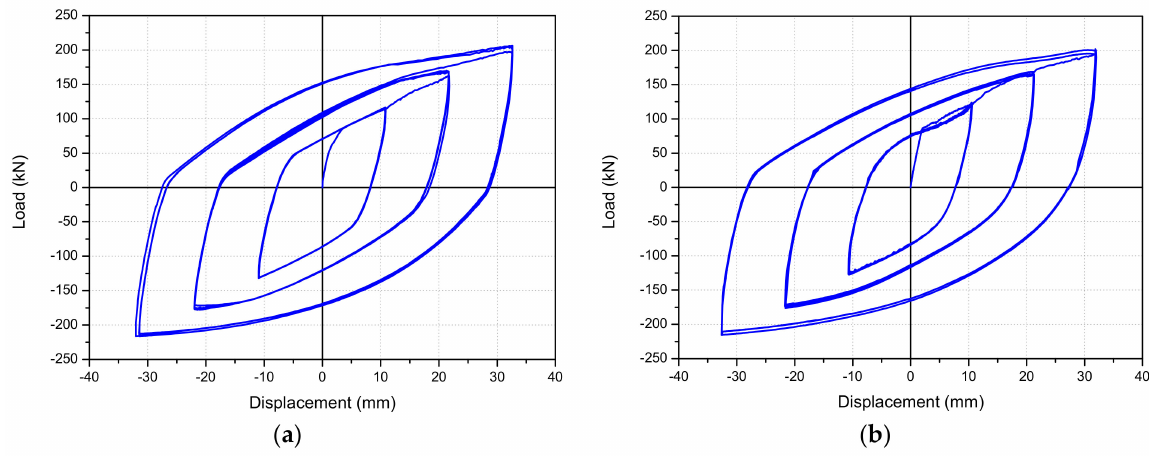
Figure 6. Load-displacement curves: ( a ) NBSD-1 and ( b ) NBSD-2